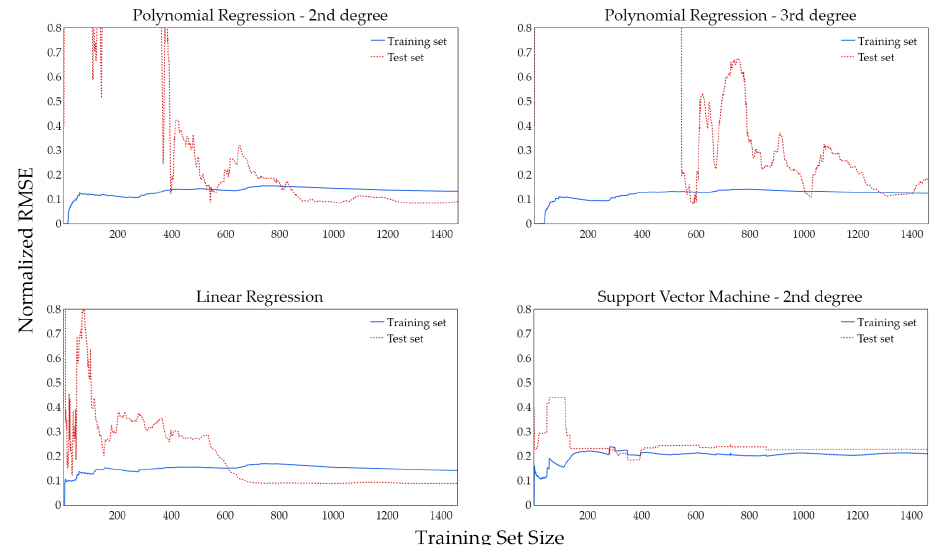
Figure 13. Learning curves of proposed models for 4th DCT frequency component (latitude: 22.5 ◦ S, longitude: 180 ◦